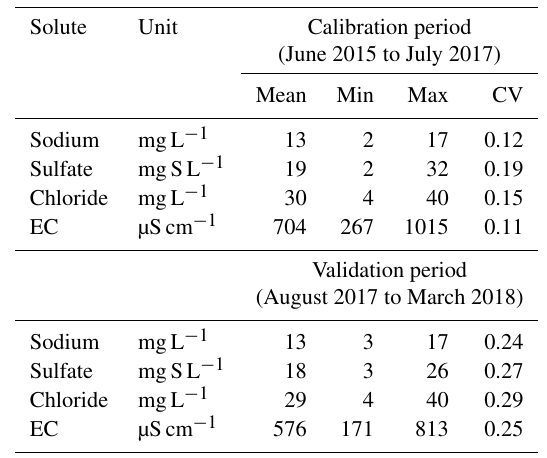
Table 1. Summary of high-frequency dissolved concentrations and electrical conductivity (EC; average, minimum, maximum values and coefficient of variation) from the River Lab at the Orgeval- ORACLE observatory, divided into two groups: June 2015 to July 2017 (calibration period) and August 2017 to March 2018 (valida- tion period).